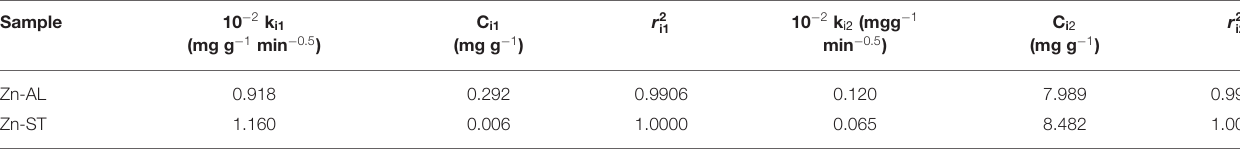
TABLE 4 | Intra-particle diffusion constants for Cu (II) removal using ZnO as adsorbent. Sample